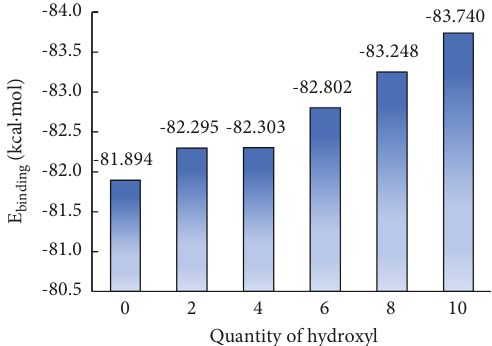
Figure 10: E binding between calcium and PVC.